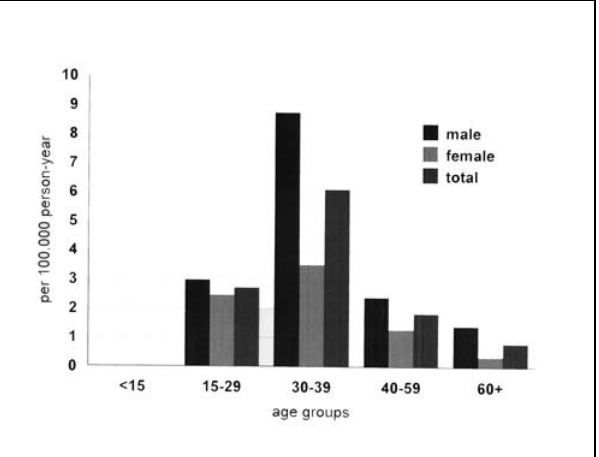
Figure 2) Estimated acute hepatitis B virus infection incidence rates from enhanced surveillance of hepatitis B virus in four health regions in Canada, 1998 to